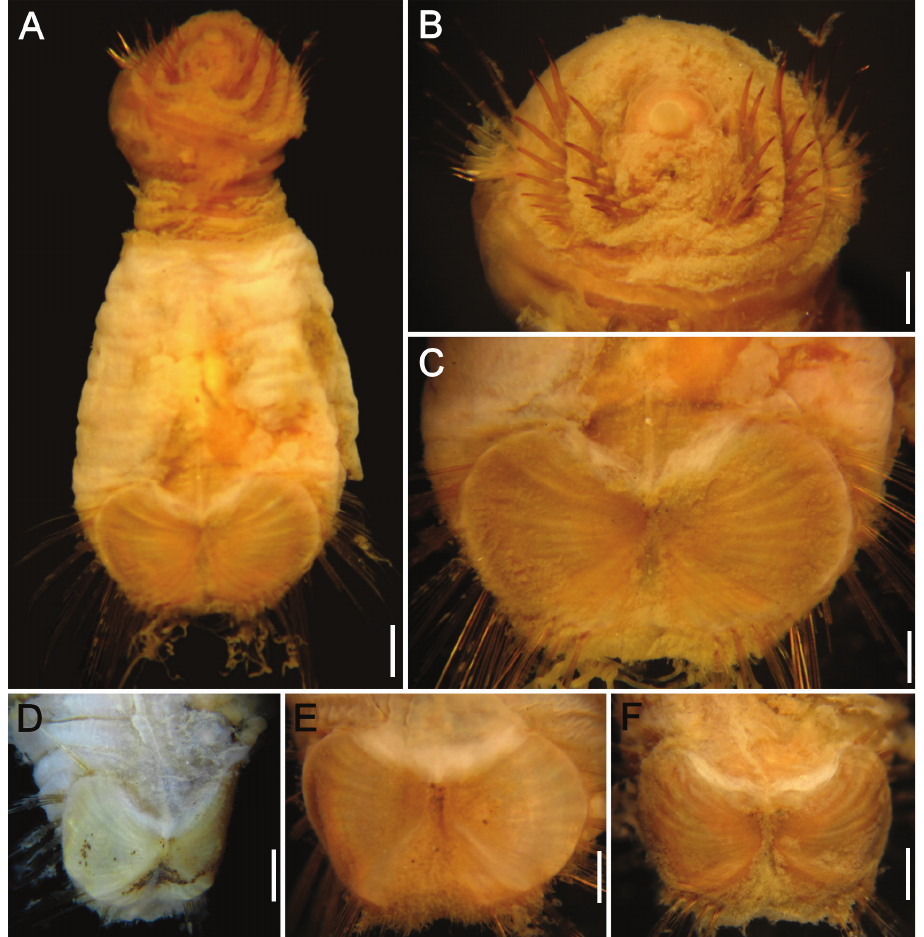
Figure 3. Caulleryaspis nuda sp. n., A Holotype (CAS 129027h), ventral view B Same, anterior end, frontal view C Same, ventro-caudal shield, frontal view D – F Paratypes (CAS 129027p), ventro-caudal shields. Bars A 1.2 mm B, E 0.6 mm C 0.5 mm D 0.8 mm F 0.9